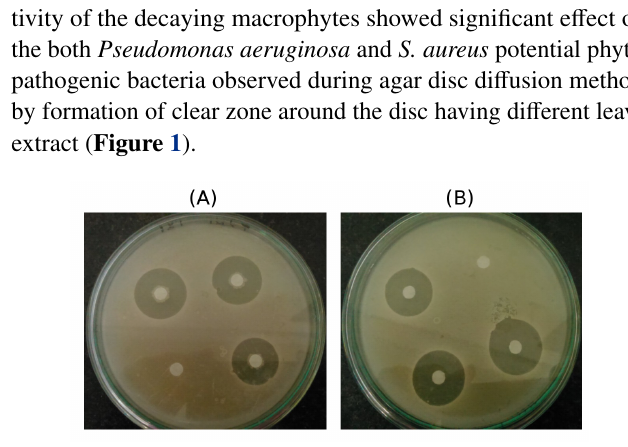
Figure 1. E ff ect of macrophytes plant extract (water, ethyl acetate, and methanol extract) with distill water as control on the bacterial pathogen on Nutrient Agar plate as Zone of Inhibition (ZOI). Where A for Pseudomonas aeruginosa and B for S. aureus